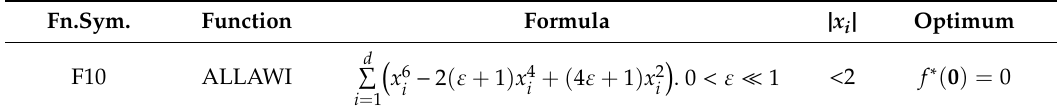
Table 2. The introduced benchmark test function.